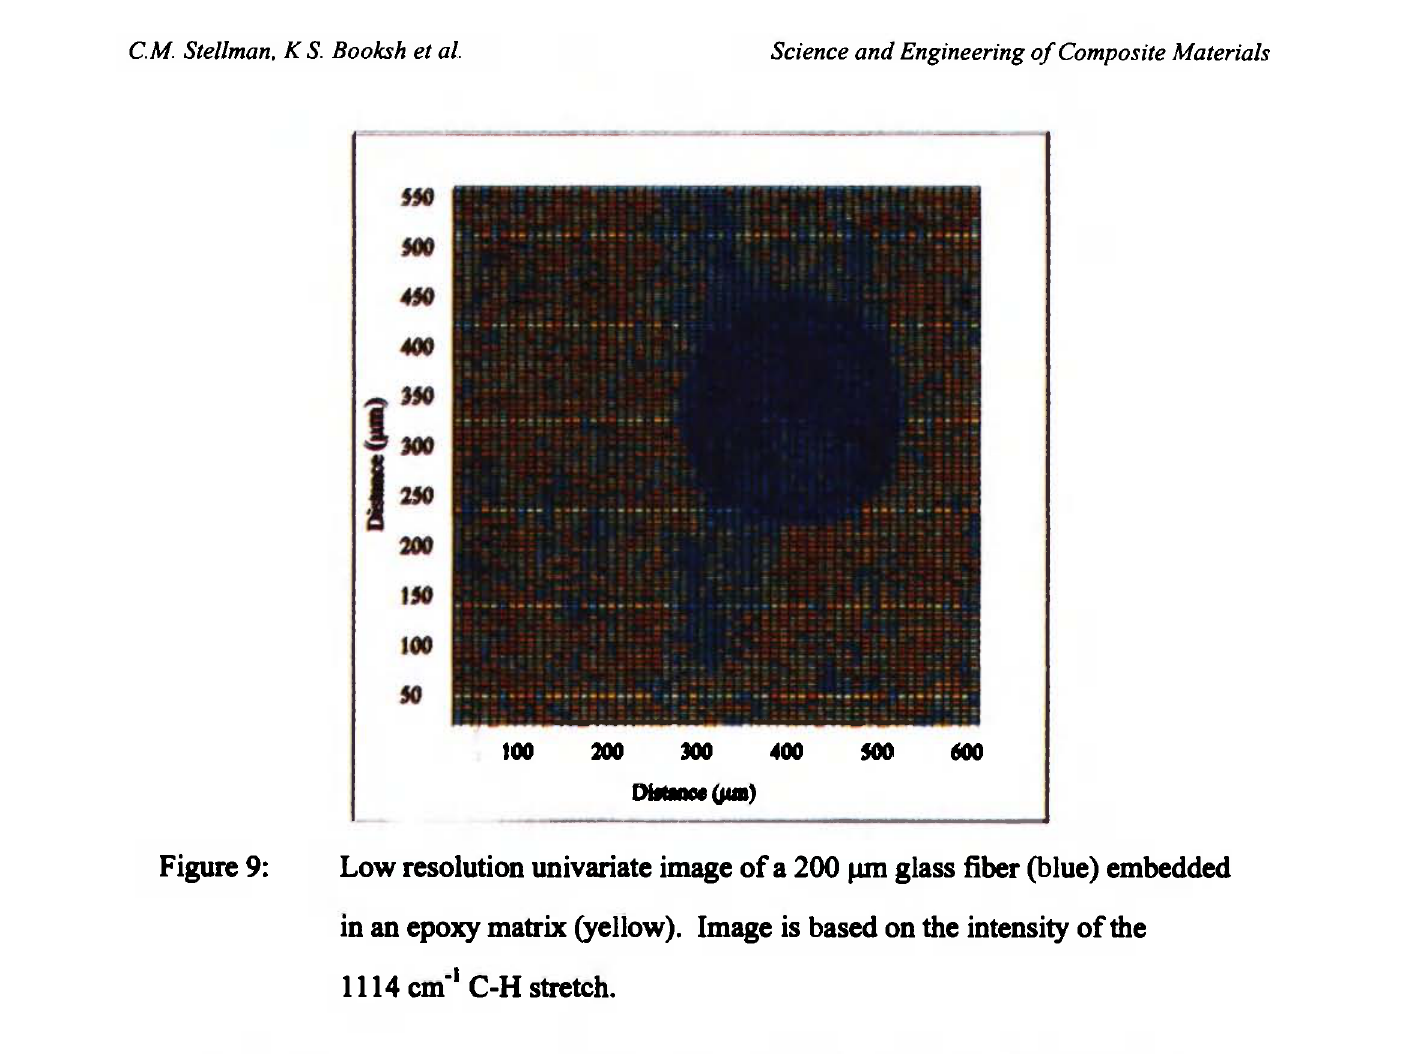
Figure 9: Low resolution univariate image of a 200 μπι glass fiber (blue) embedded in an epoxy matrix (yellow). Image is based on the intensity of the 1114 cm" 1 C-H